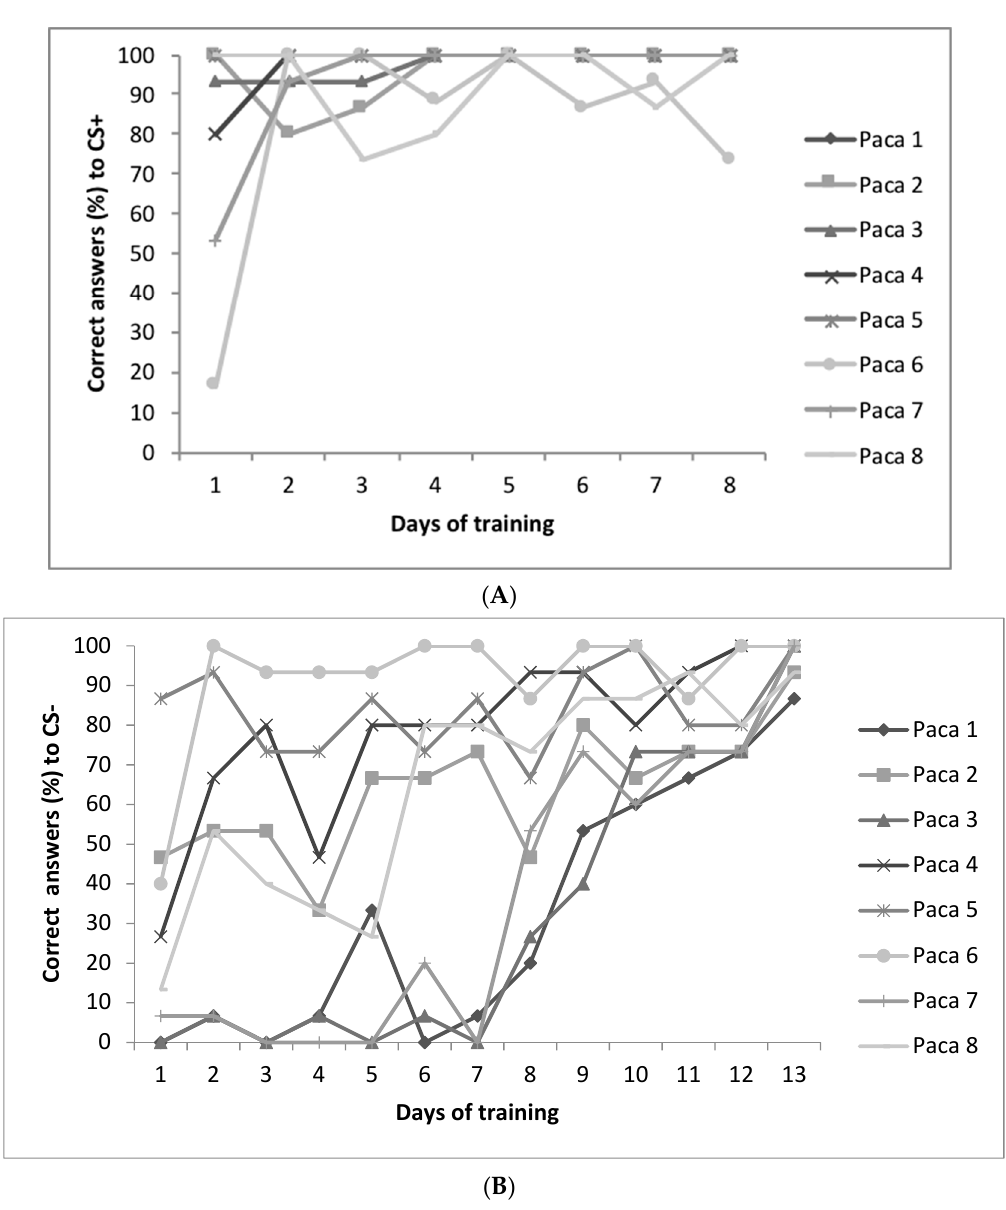
Figure 6. Number of correct responses made by pacas ( n = 8) during training sessions to CS+ cue ( A ) and to CS- cue ( B ).